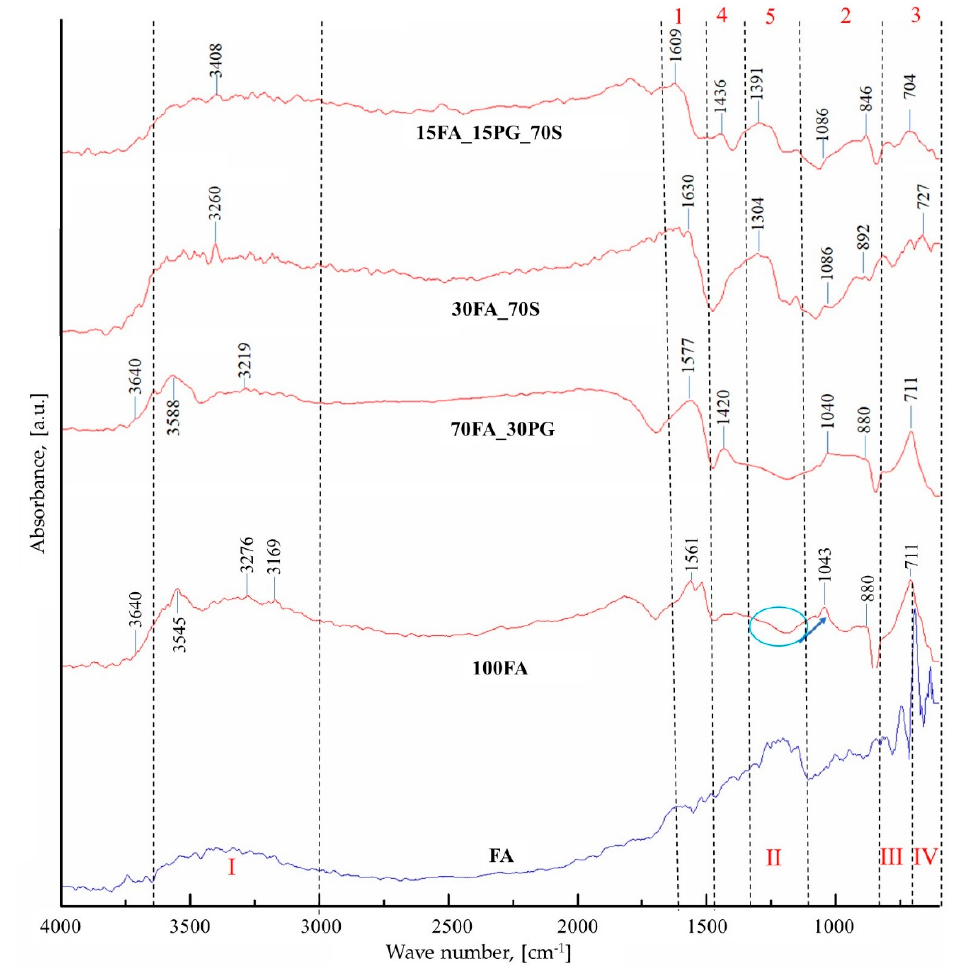
Figure 12. FTIR spectra of raw material (FA) and the analyzed samples.